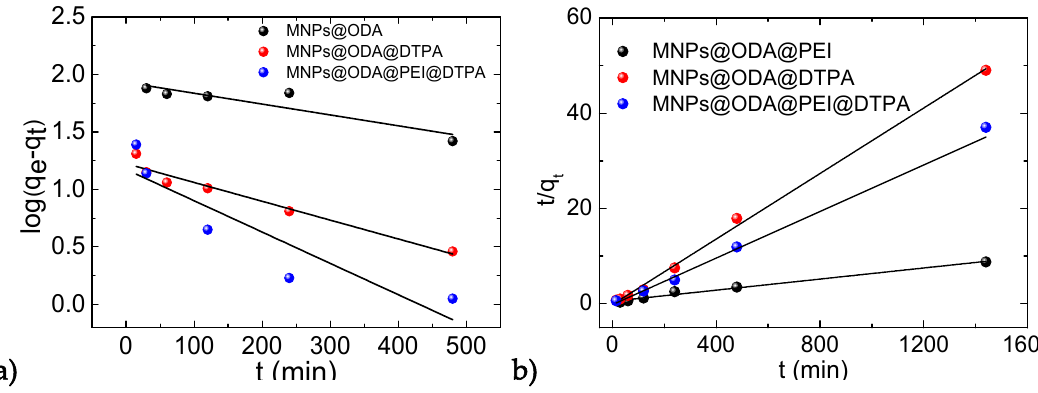
Figure 8. Pseudo-first-order ( a ) and pseudo-second-order models ( b ) of all samples.